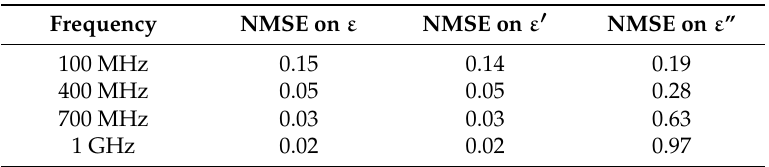
Figure 4. Oak tree trunk. Real part of permittivity ε′ ( top ) and imaginary part ε″ ( bottom ) of the reference profile and of the reconstructed profile at (from the left to the right) 100 MHz, 400 MHz, 700 MHz, and 1 GHz. Table 3. NMSE of oak tree trunk.